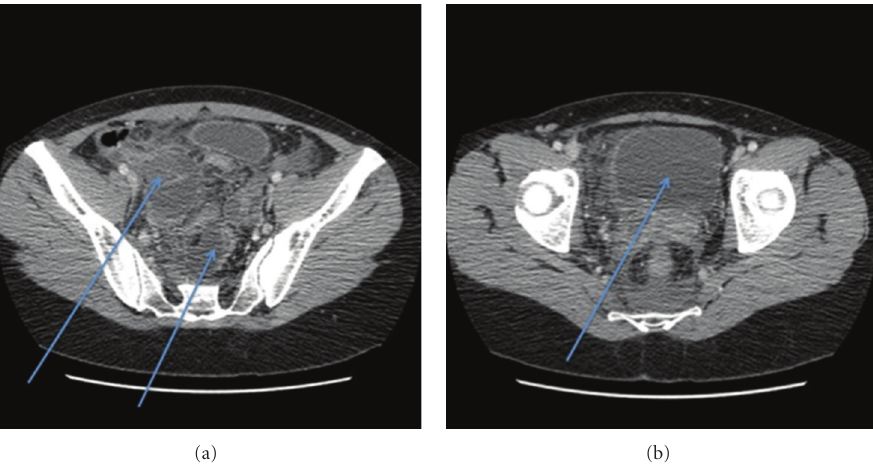
Figure 1: CT scan of the abdomen and pelvis, with contrast agent injection, on postoperative day 8, no excretory phase images. No urologic lesions were detected. (a) Presence of 2 pelvic collections (45 and 35 mm) and (b) full